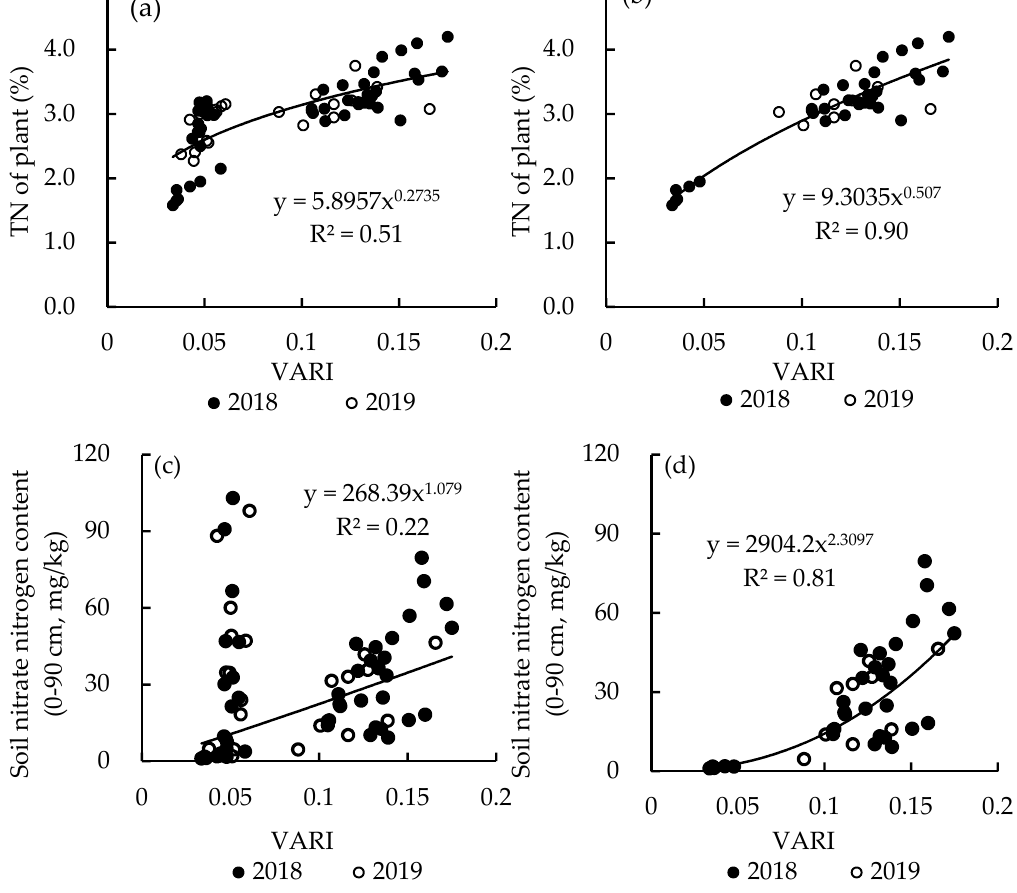
Figure 6. The impacts of P fertilizer shortage on N estimation model for the PHONEP method. ( a , b ) Are the distributions between VARI and TN of plant for the data including and excluding P0 plots, respectively. ( c , d ) Are the distributions between VARI and nitrate nitrogen content in the 0–90 cm soil layer for the data including and excluding P0 plots, respectively.